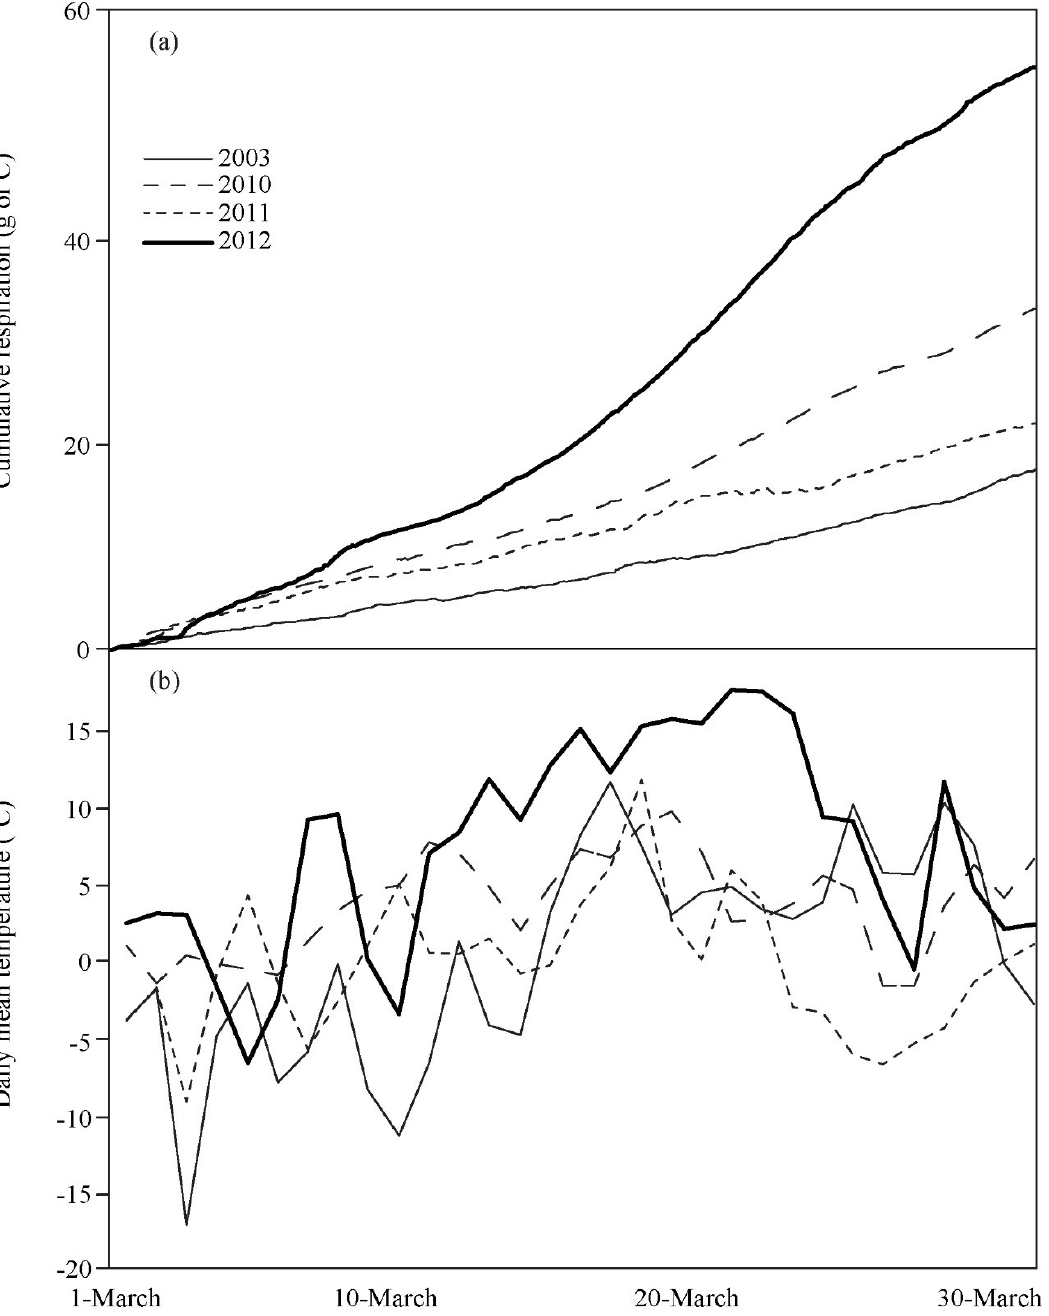
Figure 5. March ( a) cumulative ecosystem respiration (Re) and (b) daily mean temperature measured at 2 m height in the forest shown for select years. In March 2012, an extreme warm event, linked to strong climate oscillations, began around 11 March and lasted fifteen consecutive days. This event contributed to the large increase in cumulative Re as compared to other